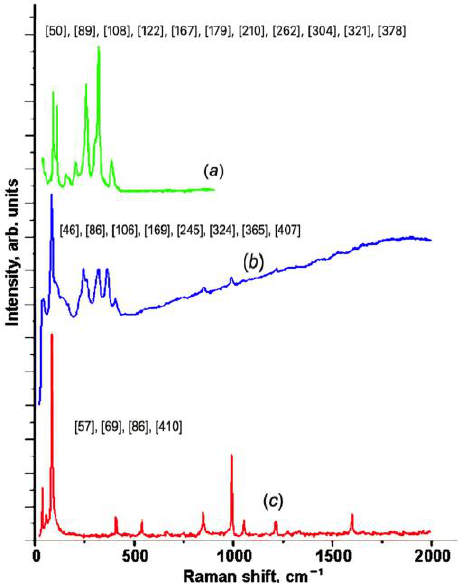
Figure 7. Raman spectra for the matrix crystal ( a ); partially intercalated ( b ); and In 1.2 Ga 0.8 S 3 · 0.5(NH 2 - C 5 H 4 N) intercalation compound ( c ).